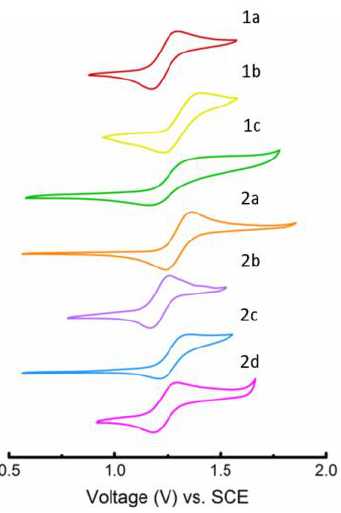
Figure 2. CV scans of 1a (red), 1b (yellow), 1c (green), 2a (orange), 2b (purple), 2c (blue), and 2d (magenta) in DCM.